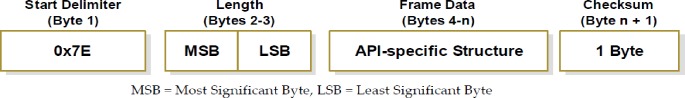
Frame structure of active API mode.